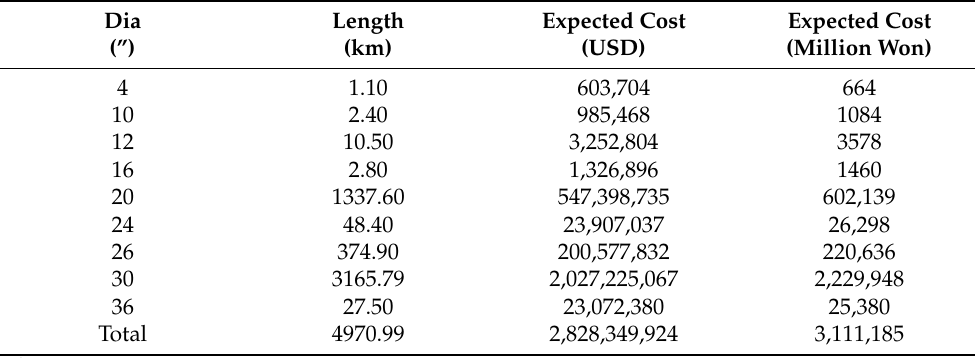
Table 7. Expected cost of hydrogen pipeline construction based on Scenario 3.